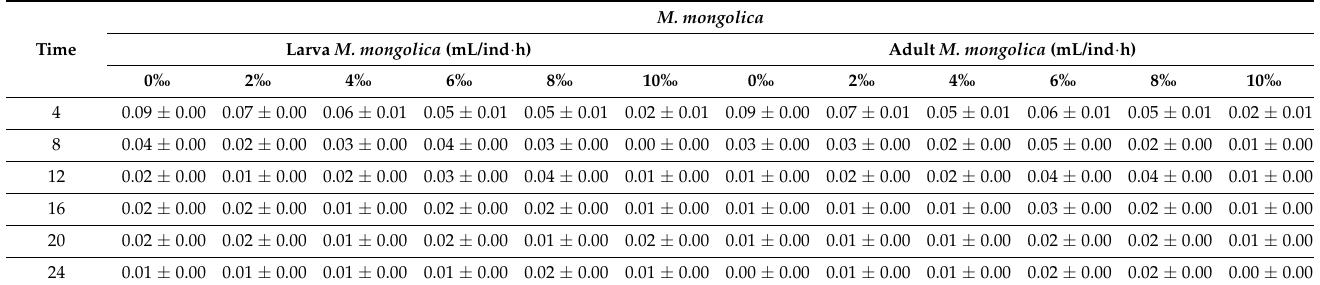
Table 6. Water filtration rates of M. mongolica at two age stages with different salinity conditions (data are listed as mean ± standard